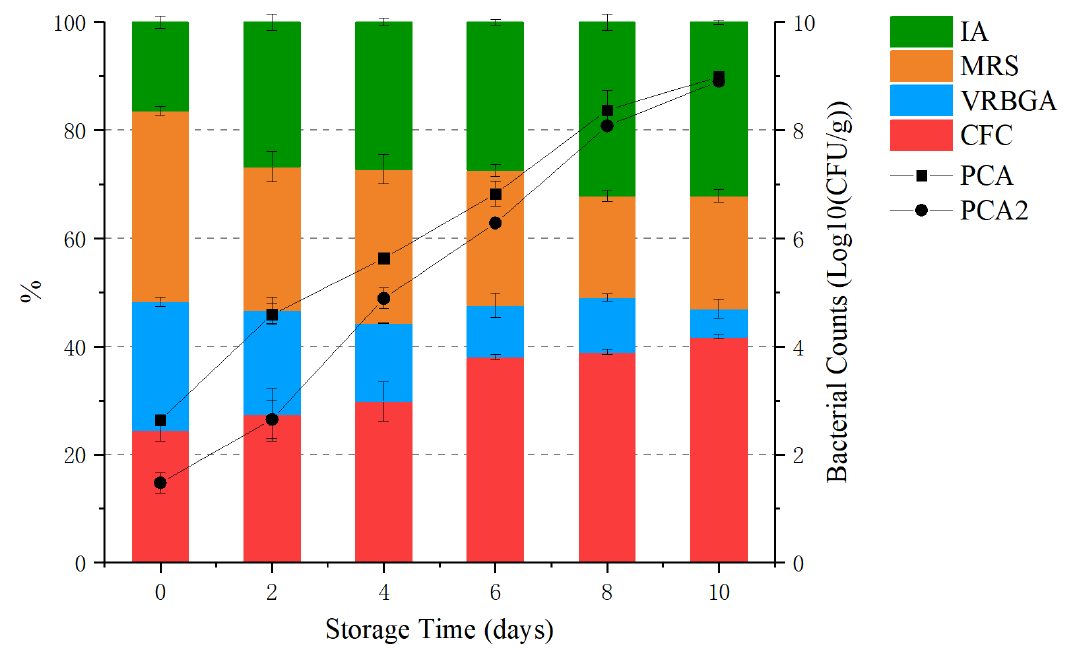
Figure 1. Total viable count of bacteria on five types of media. PCA = Plate Count agar; CFC = Pseudomonas CFC Selective agar; VRBGA = violet red bile dextrose agar; MRS = de Mann, Rogosa, Sharpe agar; IA = Iron agar, PCA2 = PCA incubated for psychrotrophs.